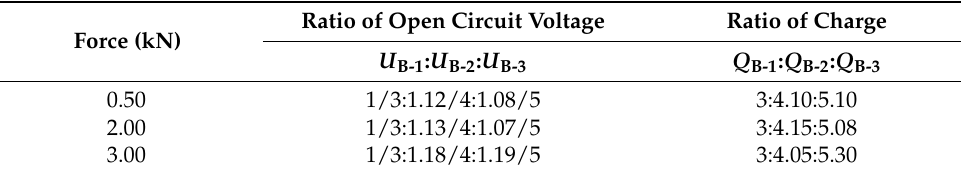
Table 6. The proportions of the values of the generated charge and voltage in Test B.